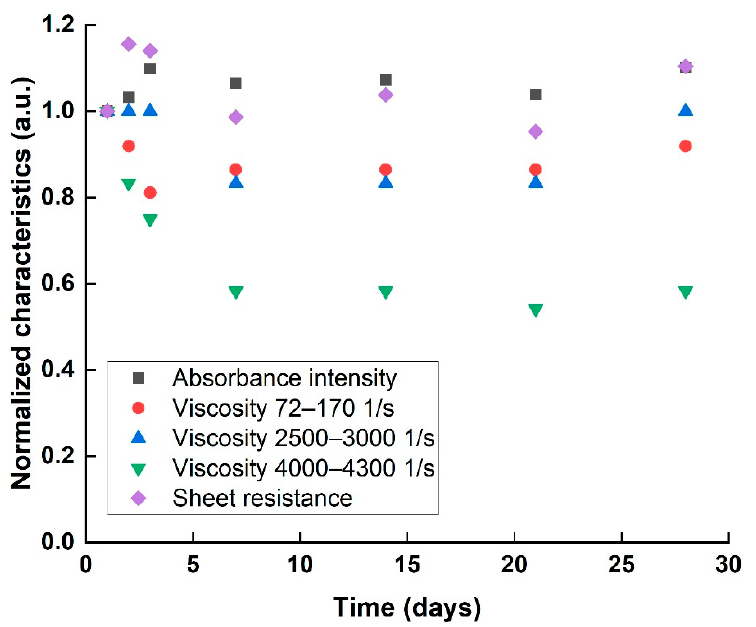
Figure 6. Absorbance intensity, viscosity in various shear rates, and sheet resistance values of aging 218 Wh dispersion process, normalized to 1st day values.